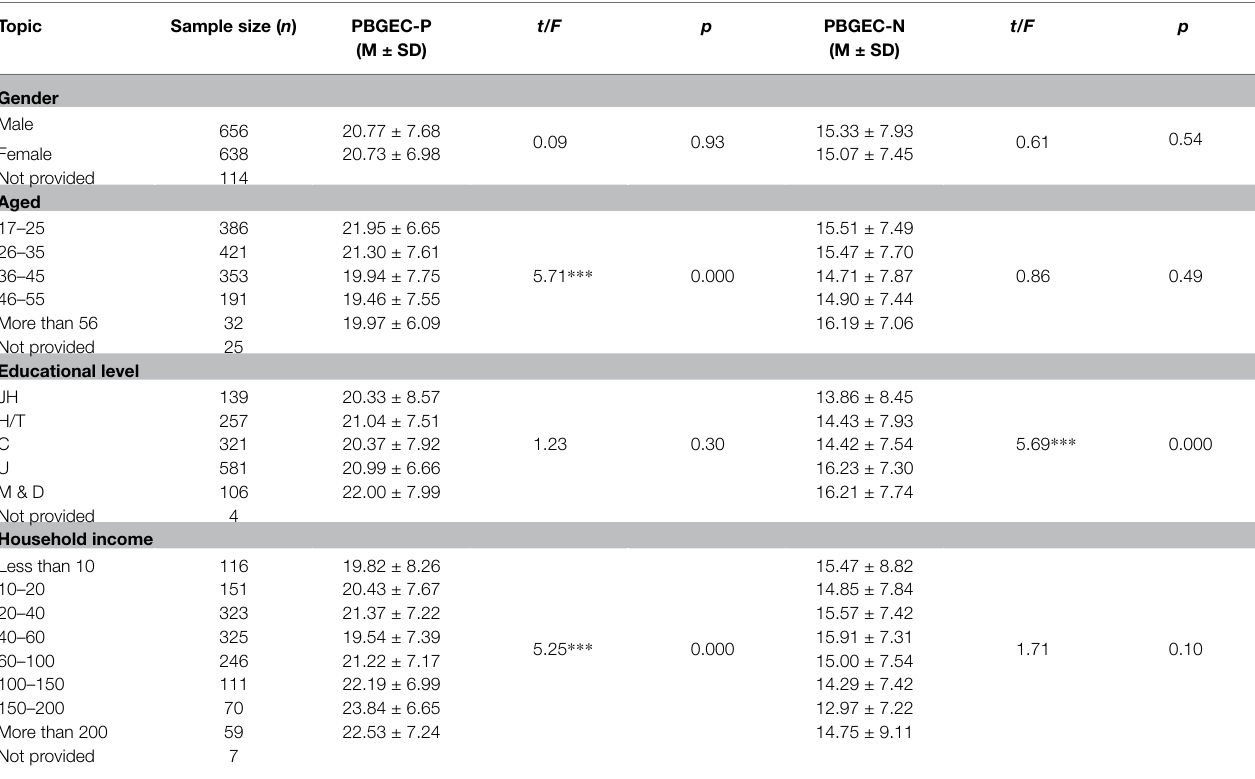
TABLE 6 | Sociodemographic characteristics on positive and negative PBGEC scores in different